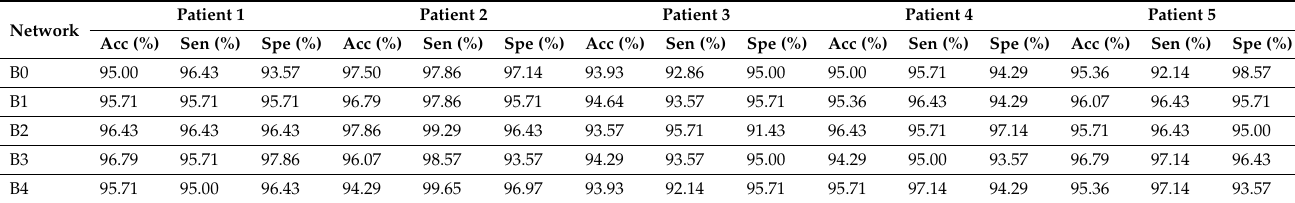
The experiment results: Table 6 shows the classification results when transfer learning was not used. Table 5. The results of Experiment 2 when transfer learning was used. Acc, Sen and Spe are the abbreviations for accuracy, sensitivity, and specificity, respectively.